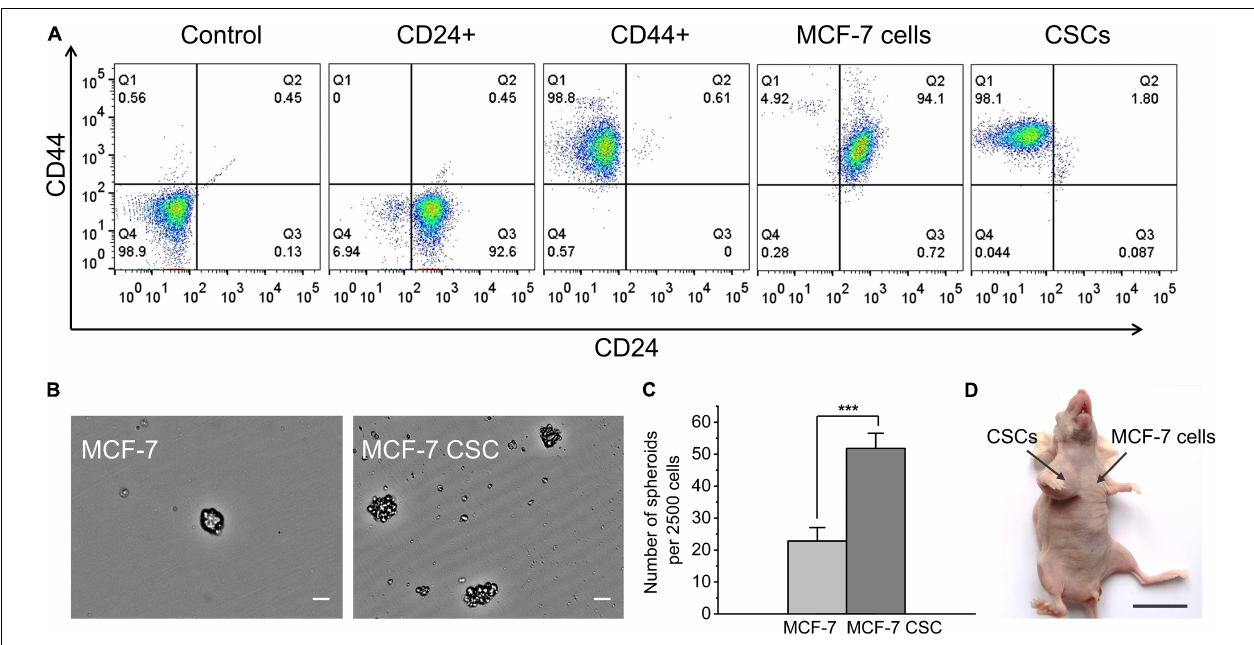
FIGURE 1 | Functional verification of MCF-7 CSCs. (A) Flow cytometry results for five groups of cells. From left to right are the control (not stained), the single CD44 stained group, the single CD24 stained group and the CD44CD24 double stained group (MCF-7 cells and CSCs). (B) Representative images of spheroids formed by MCF-7 cells and MCF-7 CSCs. Scale bars: 50 µ m. (C) Quantification of the number of spheroids derived from MCF-7 cells and MCF-7 CSCs at day 3. (D) Representative image depicting in vivo tumor formation at the injection site of 10,000 CSCs, with no tumor formation seen at the injection site of 10,000 MCF-7 cells. Scale bar: 2 cm. *** P < 0.001.